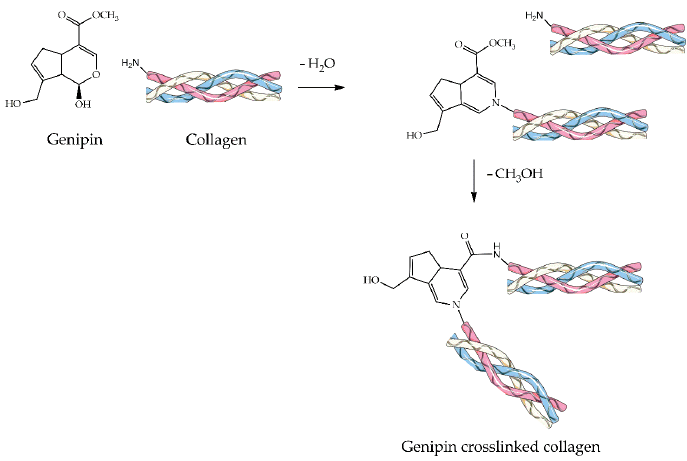
Figure 7. Schematic representation of the Genipin crosslinking 1